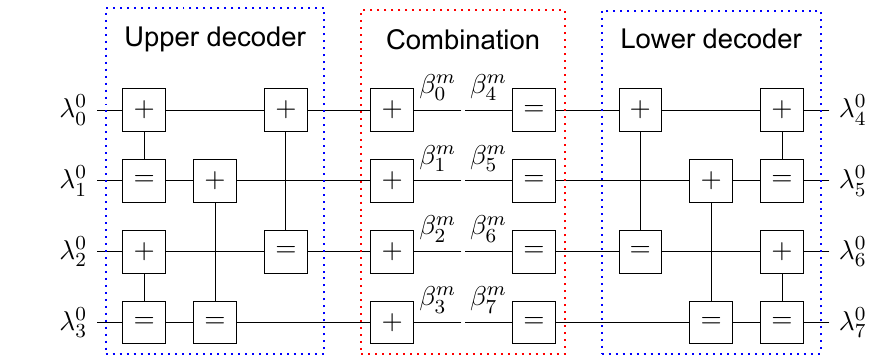
Figure 3 – Folded decoding factor graph for the polar codes of the length N = 8 . Рис 3 − Граф сверточного кода для декодирования полярных кодов длиной N = 8